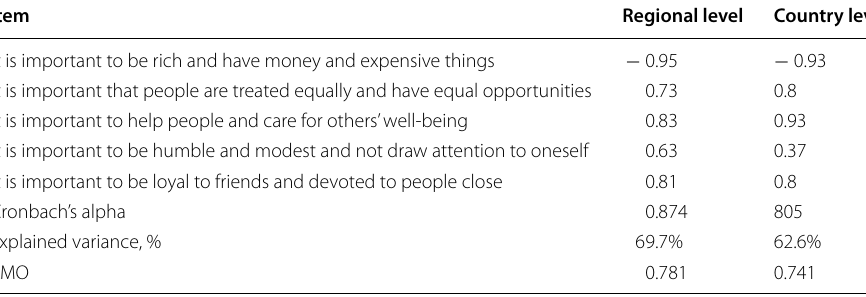
Source: calculated from European Social Survey data